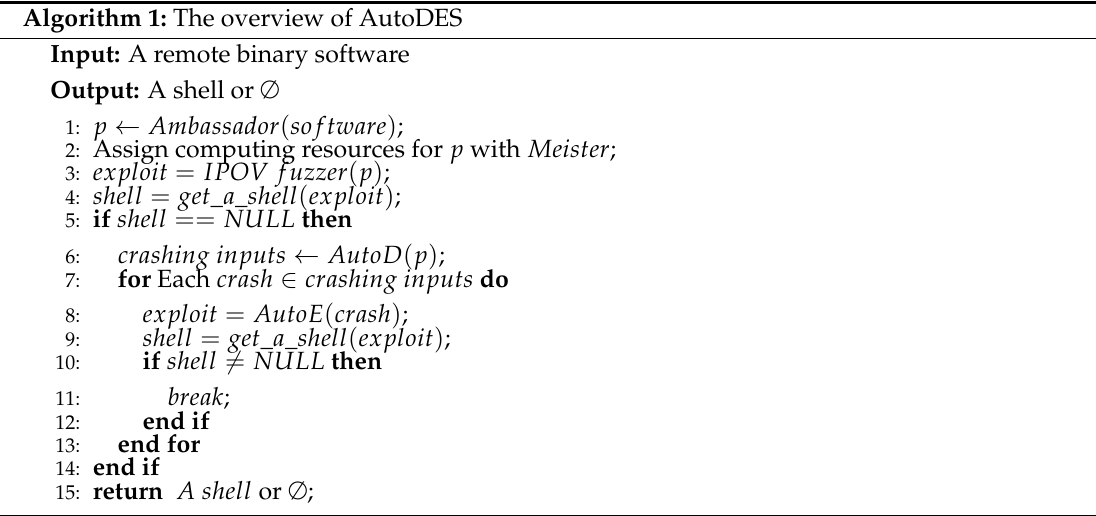
Algorithm 1: The overview of